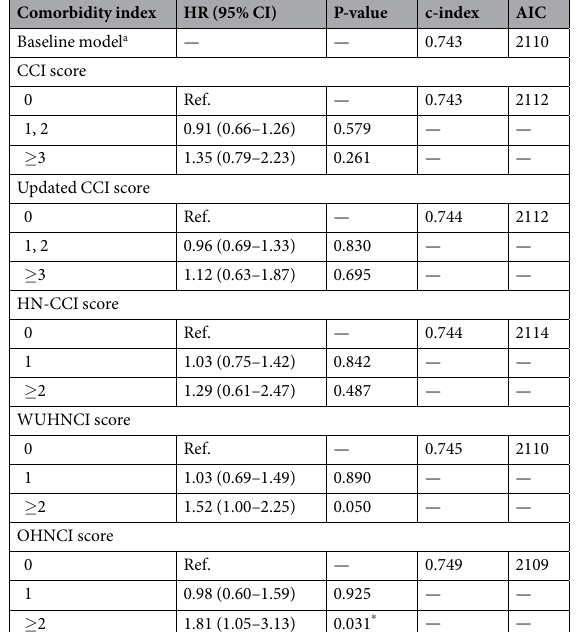
— — Table 6. Cox proportional hazards model with each comorbidity index used as a covariate in the external validation set. * P < 0.05. a Baseline model included age, sex, primary tumour site, and clinical stage and Karnofsky performance status. AIC, Akaike information criterion; CCI, Charlson comorbidity index; CI, confidence interval; c-index, Harrell’s concordance index; HN, head and neck; HR, hazard ratio; OHNCI, Osaka head and neck comorbidity index; Ref., reference; WUHNCI, Washington University head and neck comorbidity